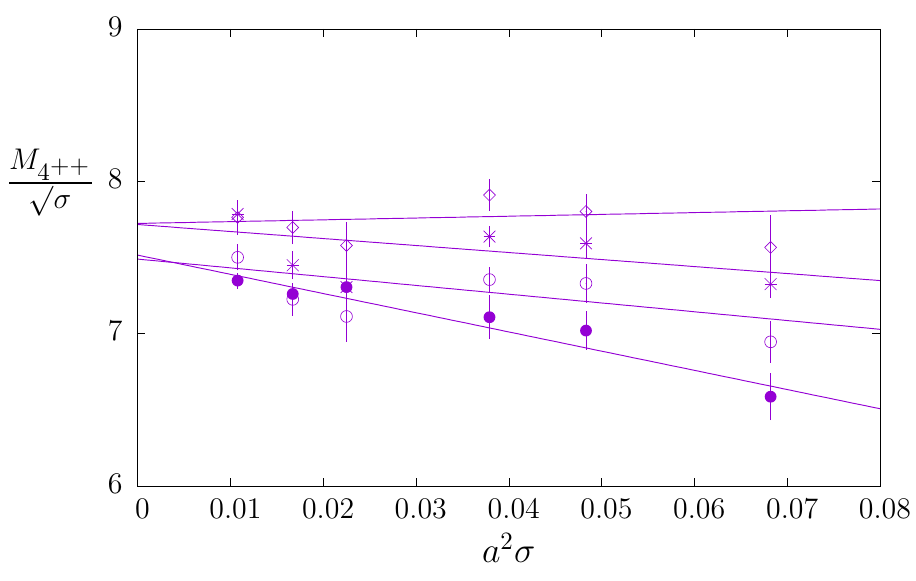
Figure 15 . Continuum extrapolation of the lightest J PC = 4 ++ glueball. Obtained from the second excited A 1 ++ ( • ), the doubly degenerate second excited E ++ ( ◦ ), the triply degenerate first excited T 1 ++ ( (cid:6) ), and the triply degenerate second excited T 2 ++ ( ? ): hence the nine components of the J = 4 ground state.